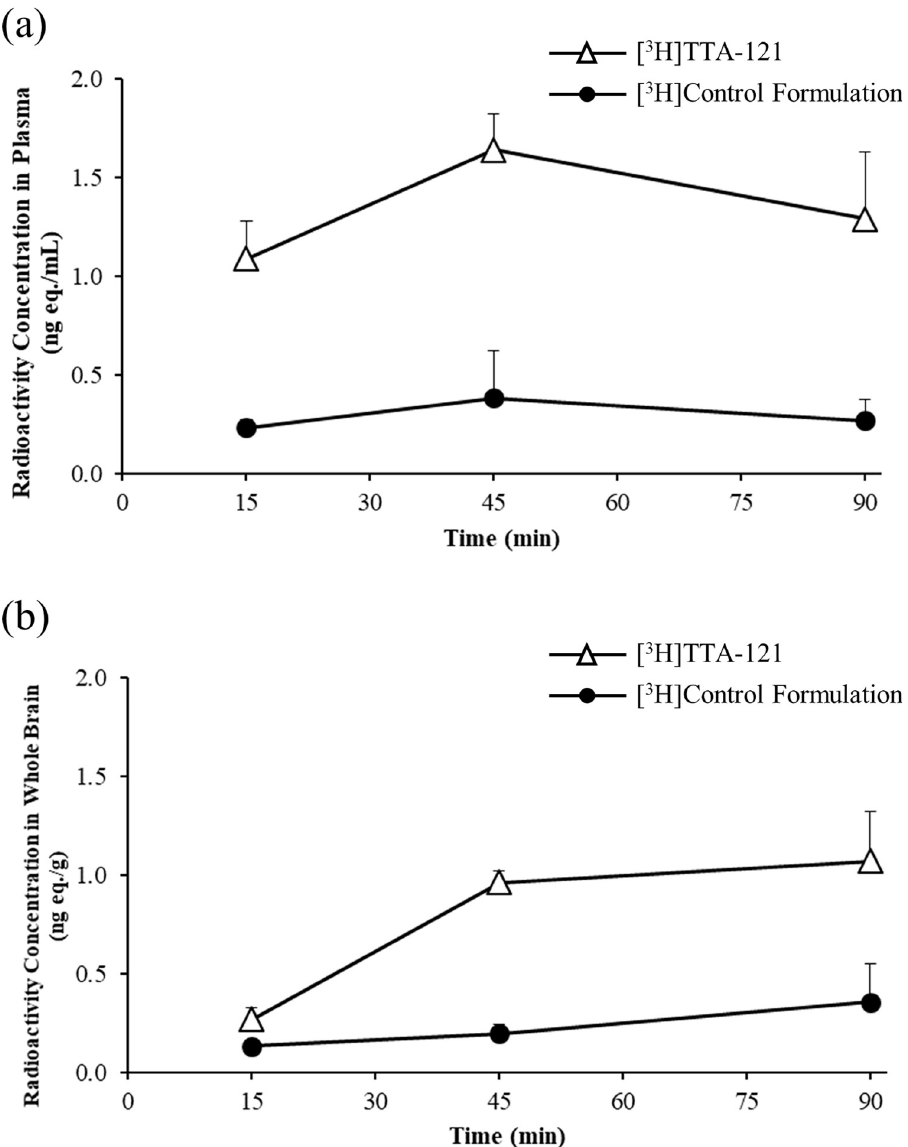
Fig 1. Time-course of radioactivity concentrations in (a) plasma and (b) whole brains after the intranasal administration of [ 3 H]TTA-121 and [ 3 H]control formulation to male rabbits (dose: 4 U/body).